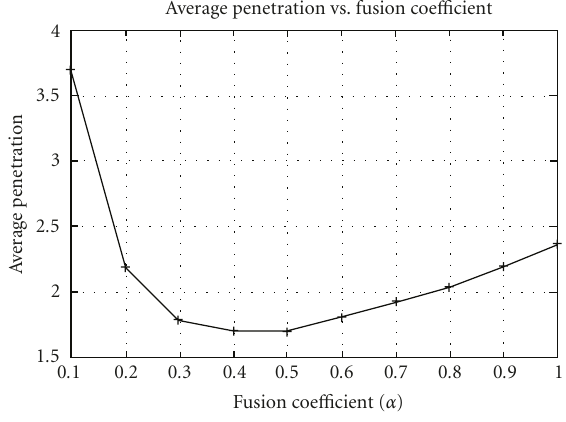
Figure 4: Average penetration versus fusion coe ffi cient ( α